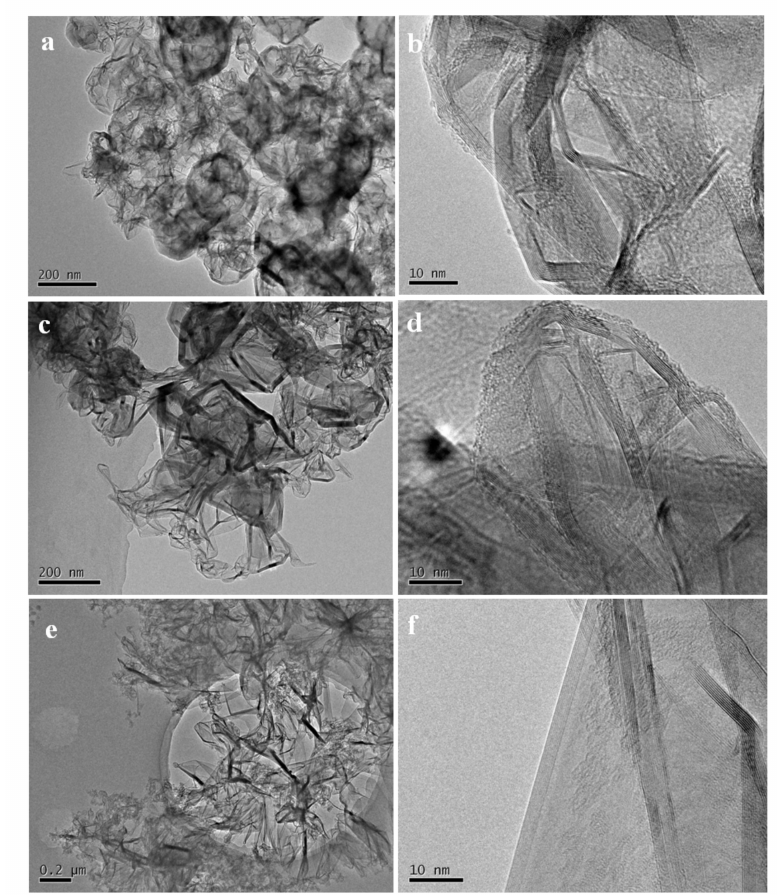
Figure 4. Typical TEM and HRTEM images of the graphene nanostructures obtained from SiC–C composites of: ( a , b ) S1, ( c , d ) S2 and ( e , f )